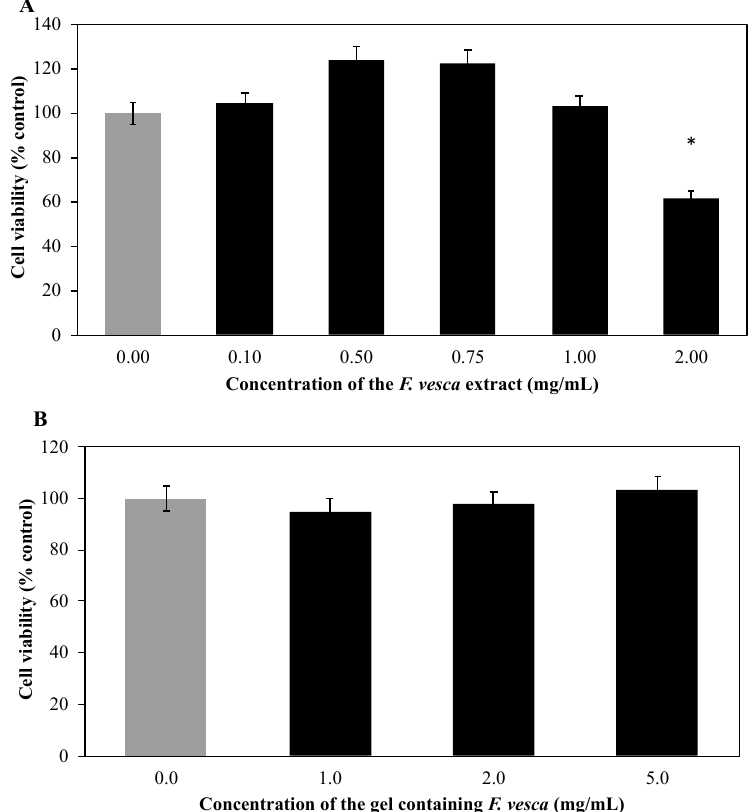
Figure 2. ( A ) Effect of F. vesca extract and ( B ) F. vesca based hydrogel on HaCaT cells viability. Cells were treated with different concentrations of extract or hydrogel formulation for 24 h and the cell viability was assessed by the MTT reduction assay. The data are presented as the Mean ± SEM of five independent experiments run in quadruplicate and expressed as percentage of control cells (100%). * p -value is significant compared to the control group ( p < 0.05).